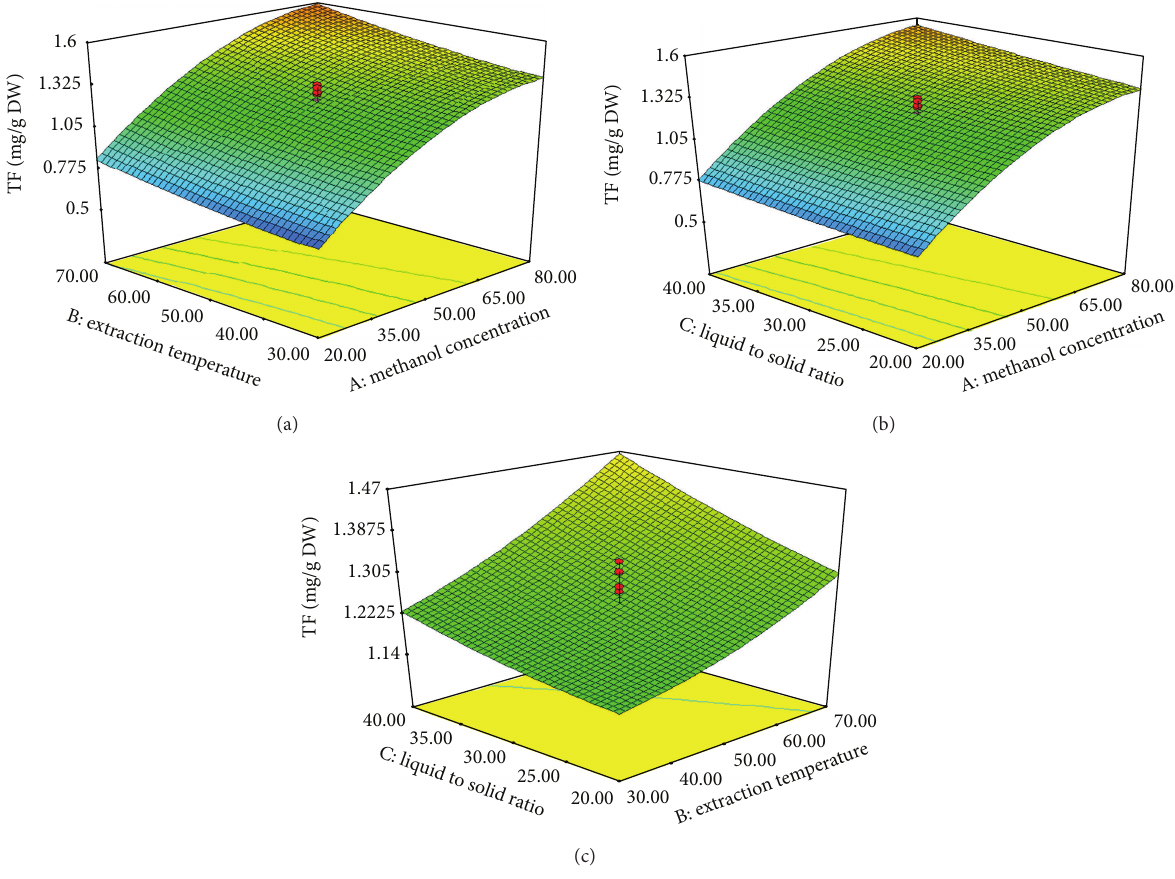
Figure 1: Response surface plots for the effects of MC (20–80%), ET (30–70 ∘ C), and LS ratio (20–40 mL/g) on the TF content of Pandan extract. MC and ET (a), MC and LS ratio (b), and ET and LS ratio